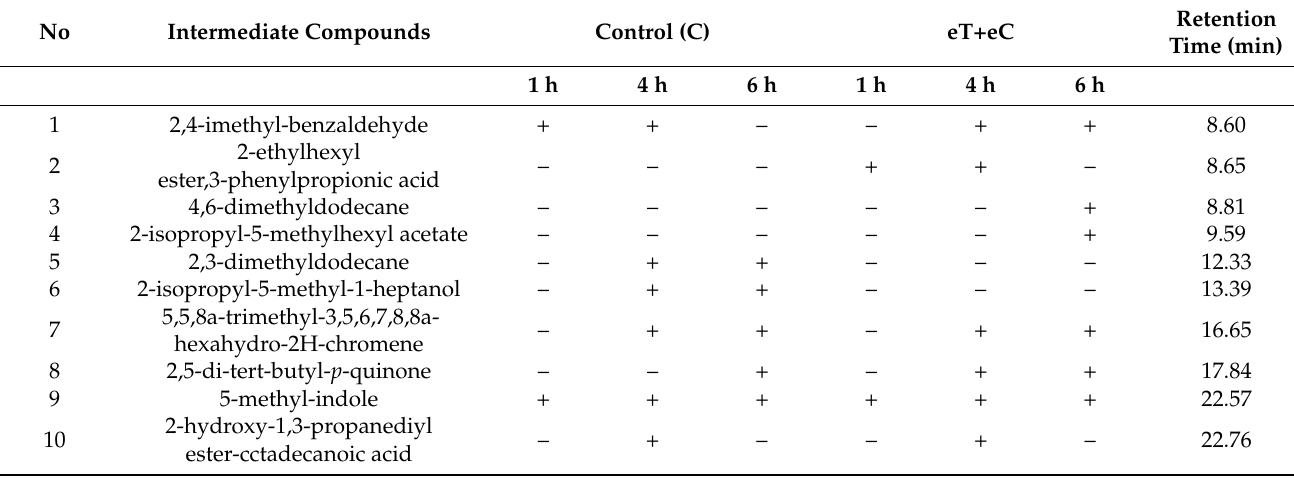
Table 3. Lignin degraded intermediates identified by GC-MS at different time courses of laccase pretreatment. No Intermediate